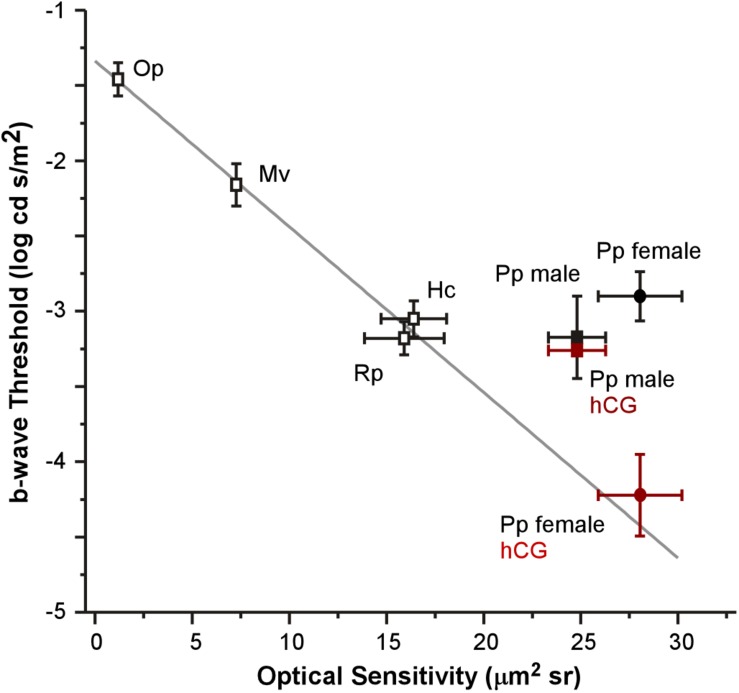
Relationship between mean (±SEM) optical sensitivities and ERG b-wave thresholds for five species: Oophaga pumilio (Op), Mantella viridris (Mv), Hyla cinerea (Hc), Rana pipiens (Rp), and Physalaemus pustulosus (Pp). Data (open symbols) and gray line fit for Op, Mv, Hc, and Rp are from Rosencrans et al. (2018). ERG thresholds for non-reproductive P. pustulosus (filled black symbols) are similar to those in other nocturnal species (non-reproductive), but do not match what is predicted by optical anatomy except for hCG treated females (red square: hCG males P. pustulosus; red circle: hCG female P. pustulosus).